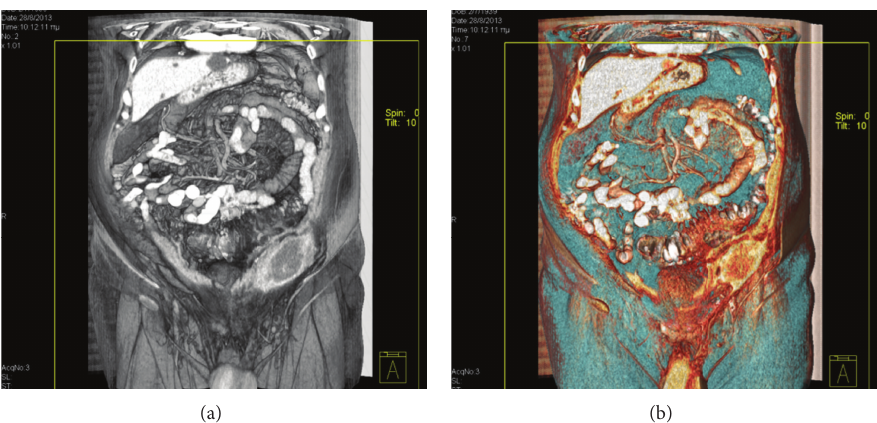
Figure 4: 3D volume rendering technique imaging demonstrates the unilateral abdominal wall thickening which is caused by the abscess in relation to other adjacent anatomical structures (a). Image (b) was reconstructed in order to depict the extraluminal air collection in region of the sigmoid colon, in continuity with the abdominal wall abscess.